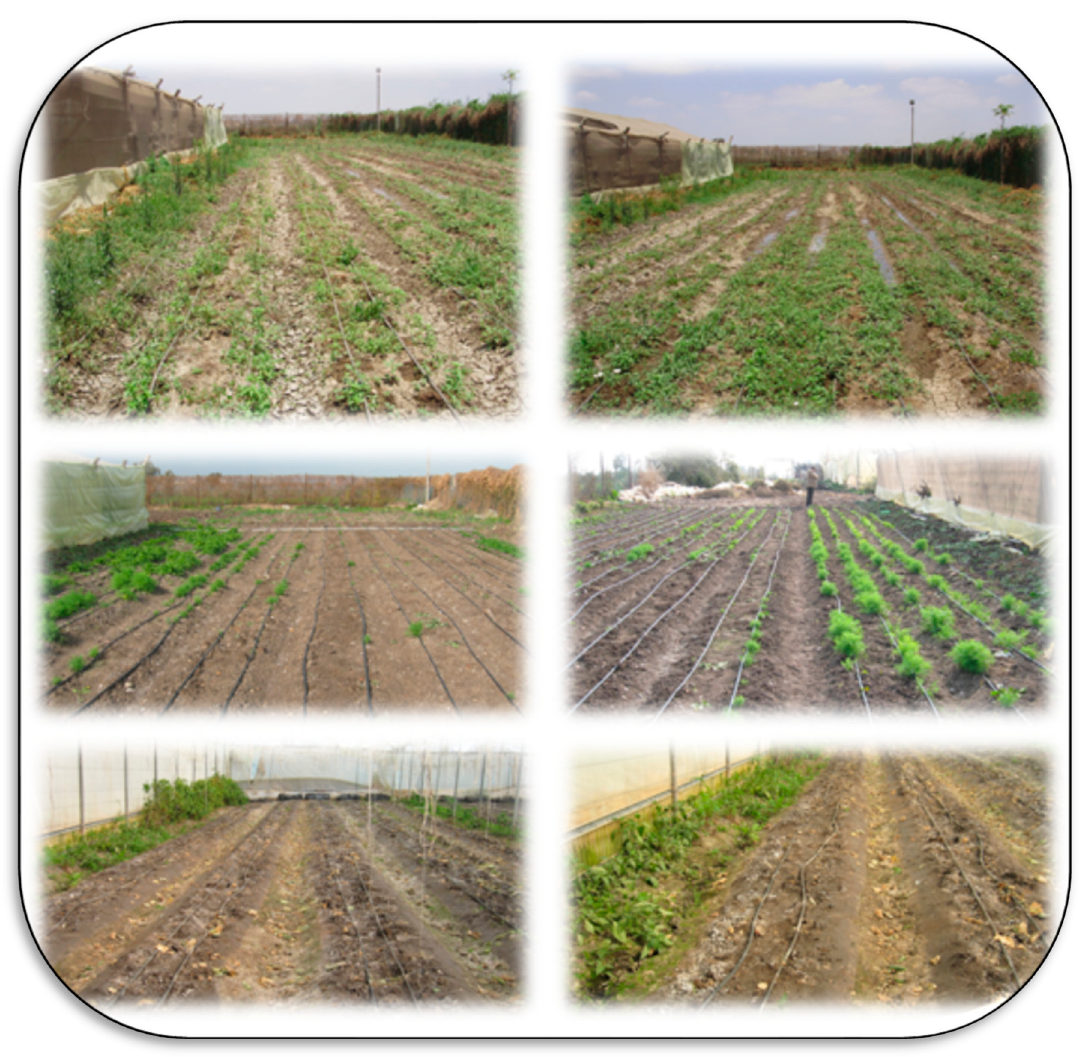
Figure 8. Salt-affected soils have general characteristics, including the accumulation of salts on the surface of the soil, missing plants due to high soil salinity in the field or under greenhouse conditions, high water table content due to poor drainage, especially in traditional greenhouses, and high temperature, which increases evaporation from the soil surface and thus accumulation of salts on the soil surface. Photos by El-Ramady.